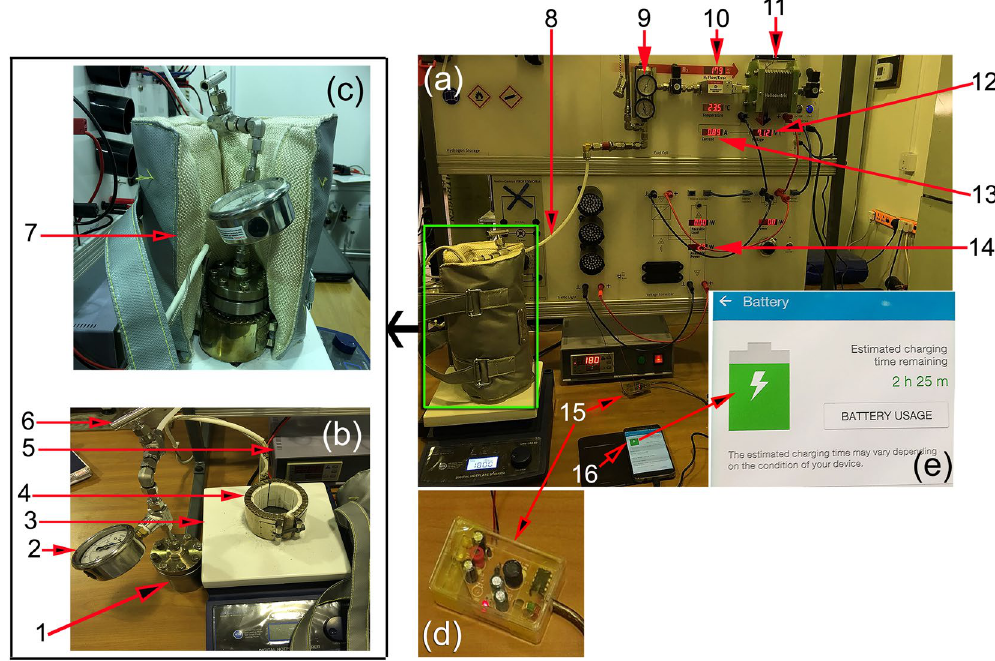
Figure 9. Integrated hydrogen storage tank invented in the present work coupled with 40 W/4.5 A proton exchange membrane (PEM) fuel cell. ( a ) prototype bench-lab of hydrogen storage tank ( b , c ) designed and manufactured in the present work integrated with PEM fuel cell. The system consists (1) hydrogen storage tank filled with nanocomposite MgH 2 /5 wt.% TiMn 2 powders, (2) high-pressure hydrogen-gauge, (3) hot-plate, (4) jacket heater with copper heating-elements, (5) jacket heater temperature controller, (6) hydrogen uptake/ release controlling valve (7) jacket temperature insulator, (8) tube connecting the hydrogen storage system with the fuel-cell unit, (9) H 2 -PEM input gauge monitor, (10) hydrogen-flow indicator, (11) 40 W/4.5 A PEM- type fuel cell, (12) voltage indicator, (13) electric current indicator, (14) available power produced by the fuel cell, (15) 5 V voltage regulator ( d ), (16) cell-phone device, showing cell phone battery charging monitor with a different magnification in ( e